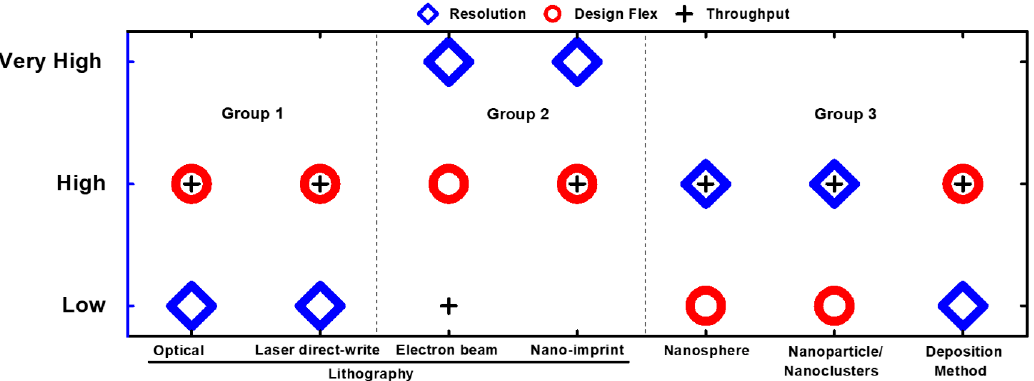
Figure 6. A qualitative comparison of characteristics belonging to different methods for fabricating the nanostructures.